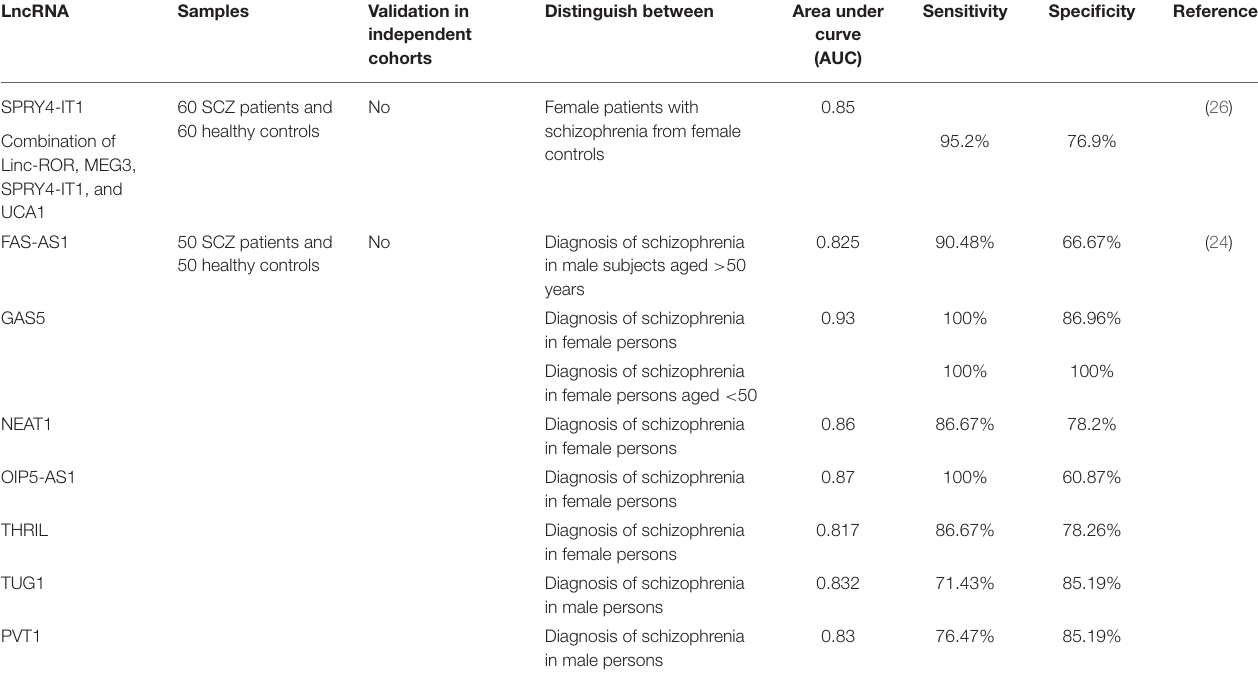
TABLE 3 | Diagnostic value of lncRNAs in